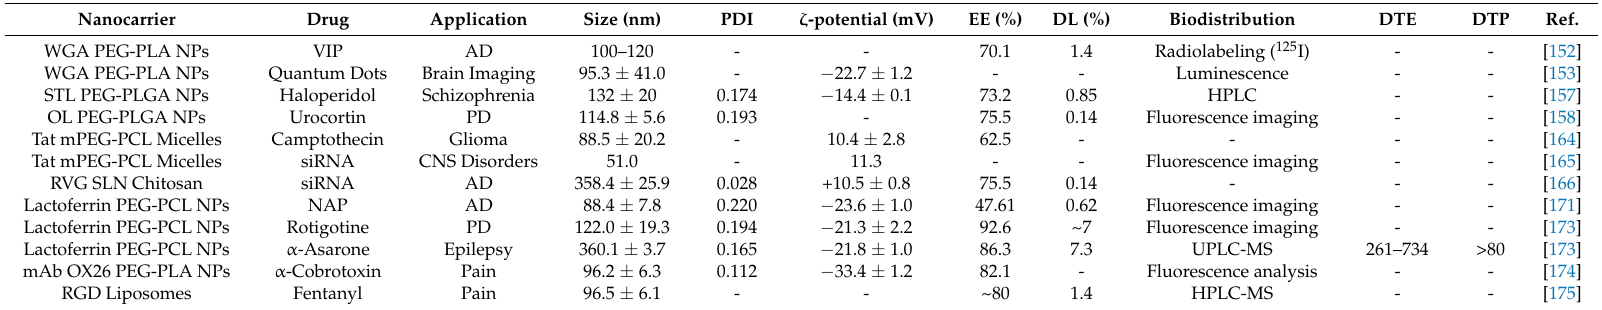
Table 3. Targeted nanocarriers studied for nose-to-brain